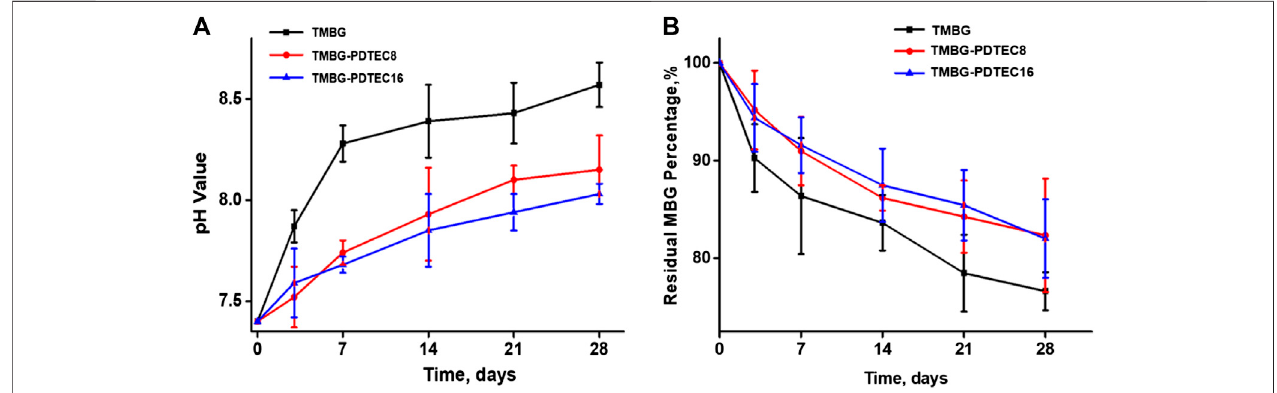
FIGURE6| DegradationbehaviorsofTMBGscaffolds: (A) thepHvaluechangeofTris-HClbuffersolutionincubatedwithscaffoldsatdifferentsoakingperiods; (B) the degradation curves of scaffolds as a function of soaking time. ( n (cid:2) 3).